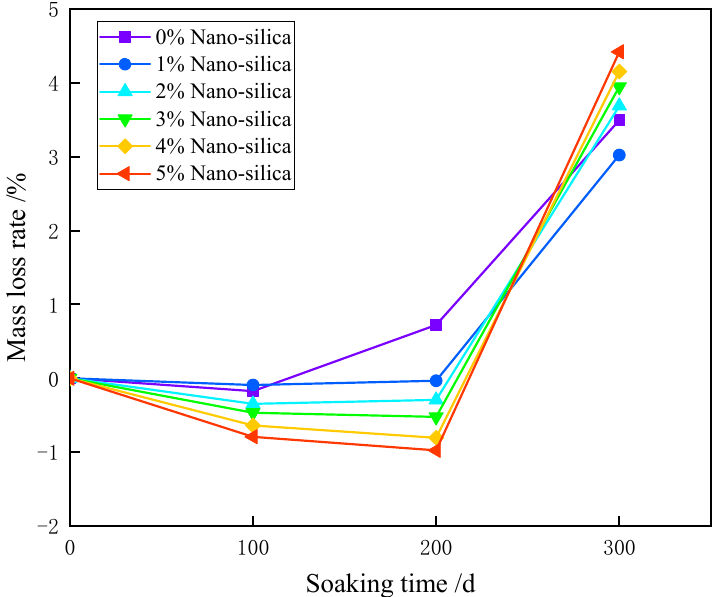
Figure 4. The time-dependent mass loss of HPC specimens subject to sulfate erosion.